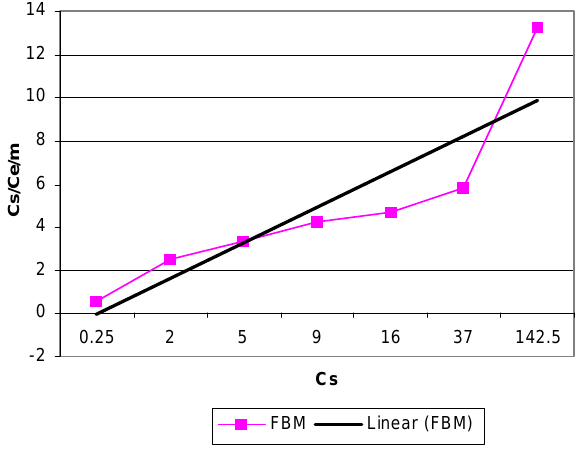
Figure 11: Langmuir adsorption Isotherm for Batch study using FBM